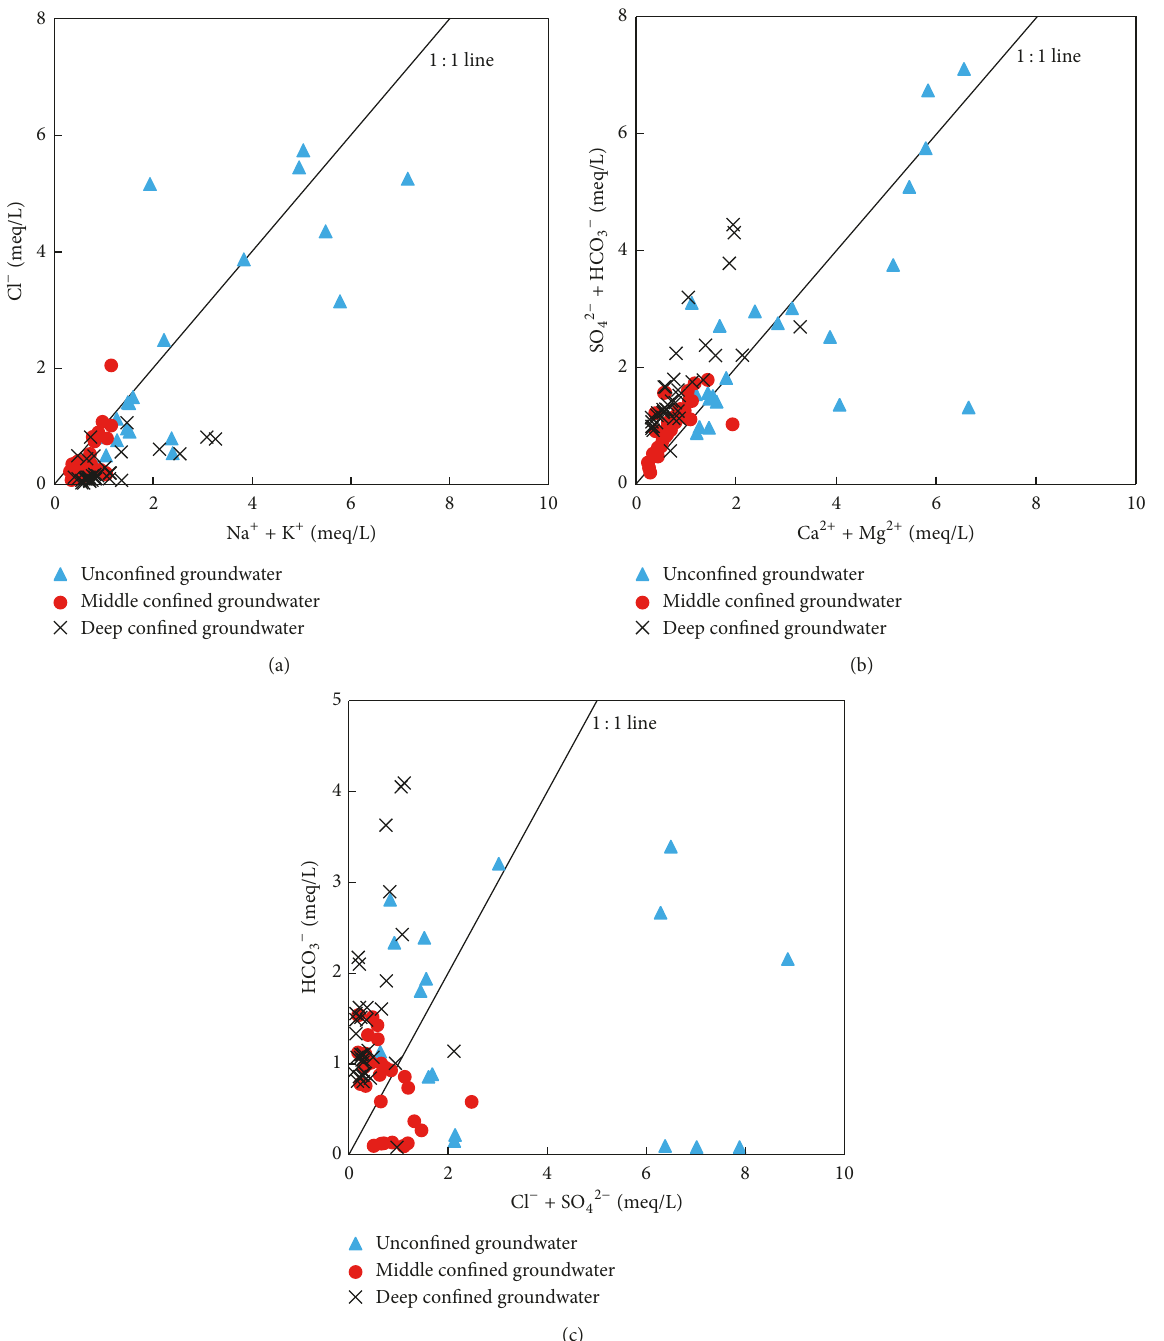
Figure 8: Bivariate plots of ionic relation. (a) Cl − versus Na + + K + . (b) SO 42− + HCO 3− versus Ca 2+ + Mg 2+ . (c) HCO 3− versus (Cl − + SO 42− ).